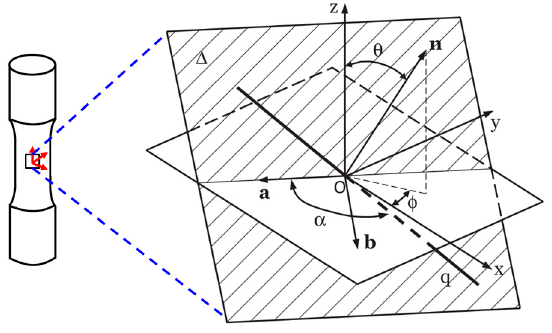
Figure 1. Determination of critical plane for multiaxial stress state component.